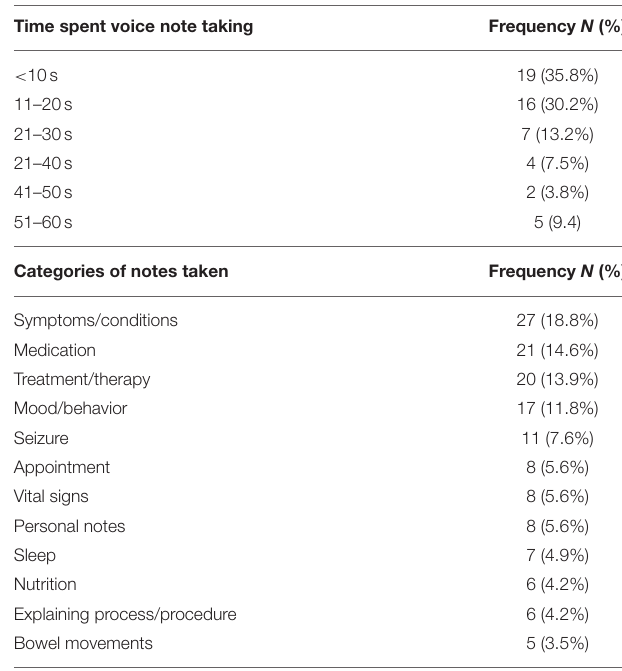
TABLE 5 | Time spent on taking voice interactive notes and categories of